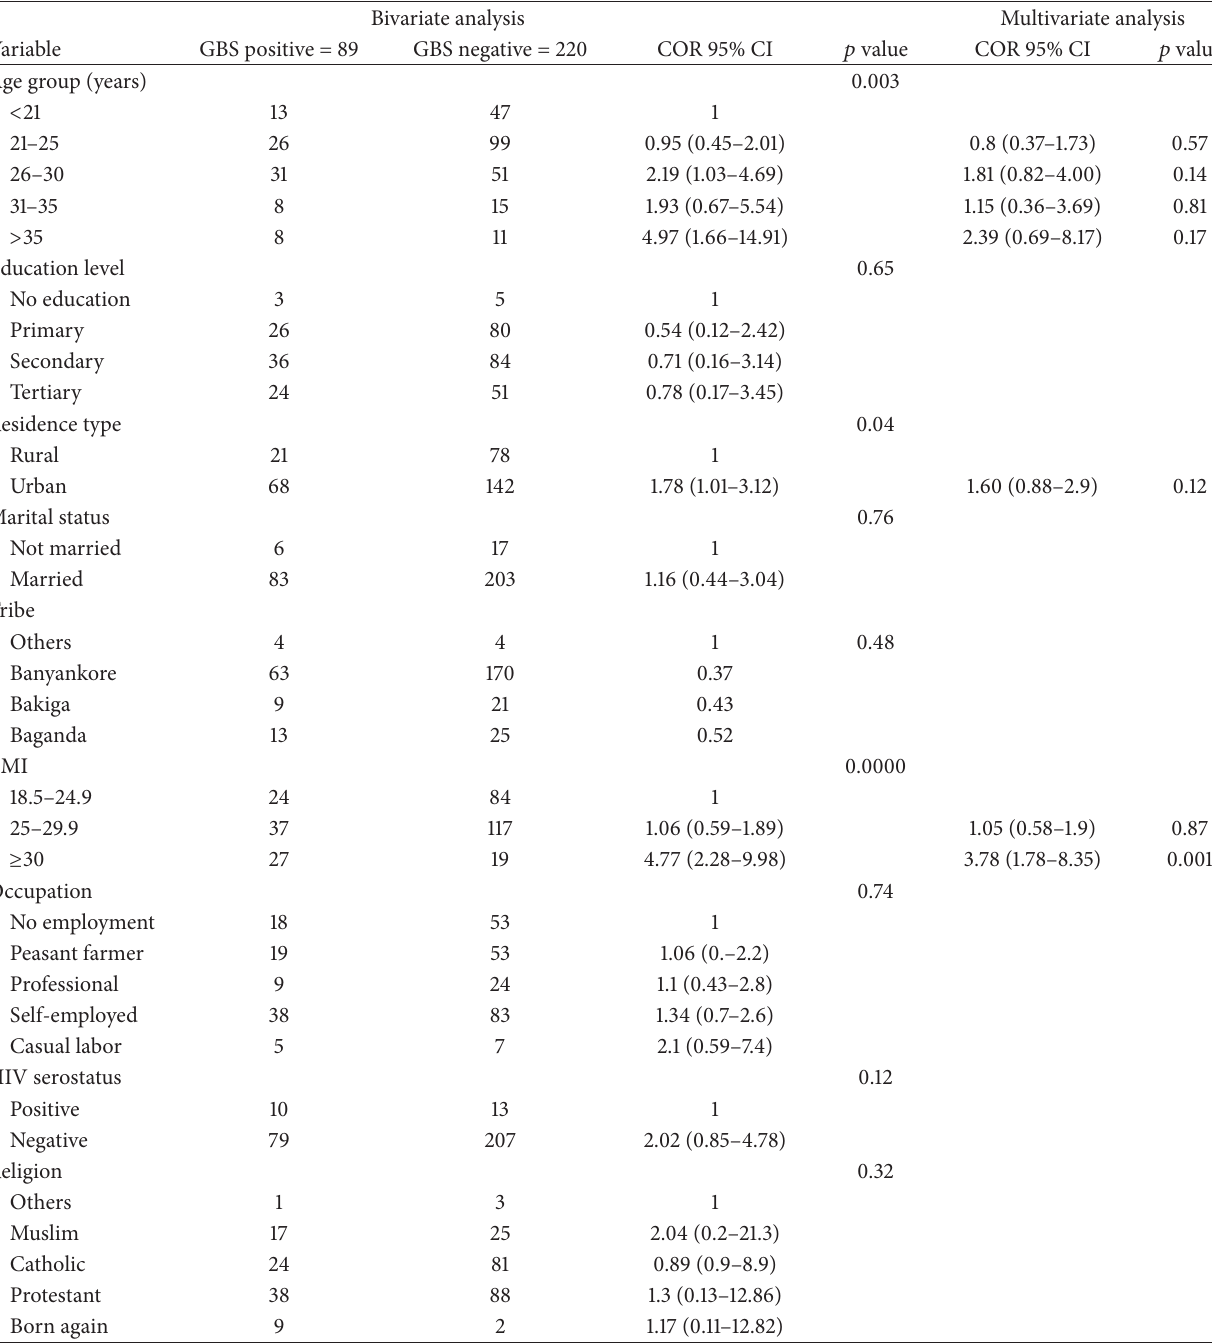
Table 3: Association between GBS colonization status and potential sociodemographic factors. Bivariate analysis Multivariate